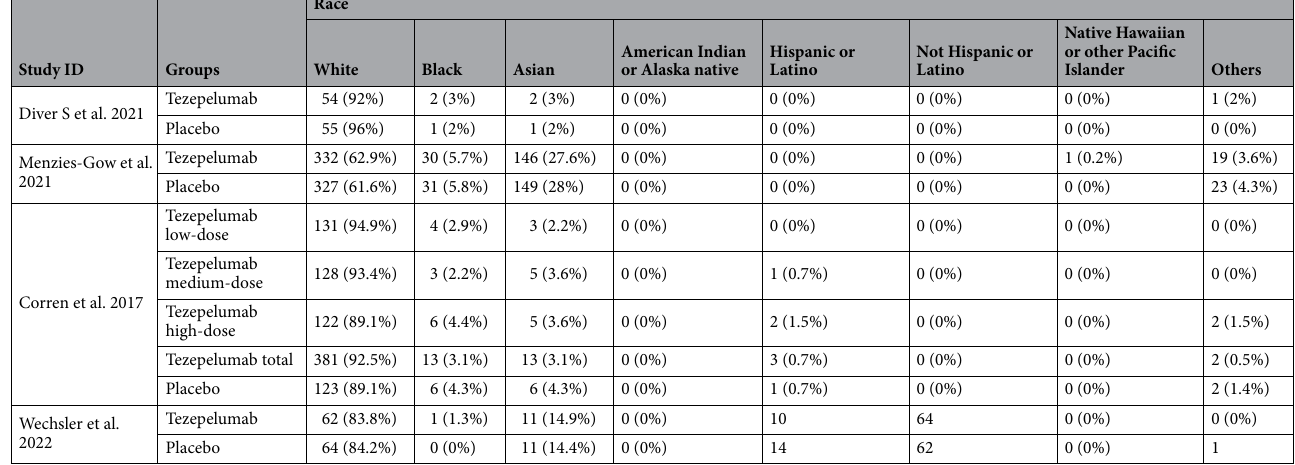
Table 3. Baseline characteristics of enrolled patients in each included study.